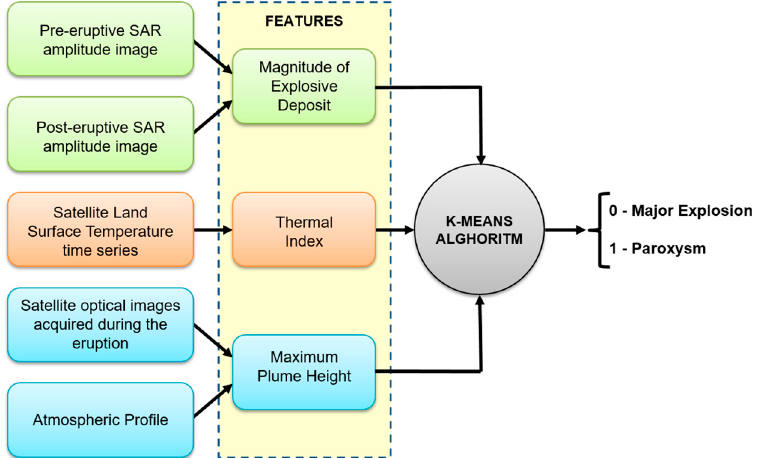
Figure 2. Workflow of the unsupervised classifier showing the transformation from satellite raw data to descriptive features that are then fed to the k-means algorithm. It provides a binary outcome, i.e., zero for Major Explosions and one for Paroxysms.